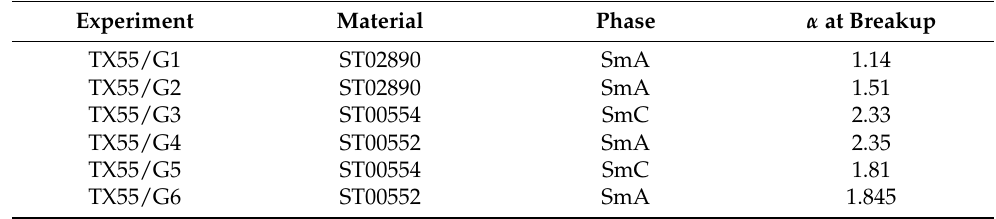
Table A1. Ruptures under normal gravity conditions with a bond number of approximately